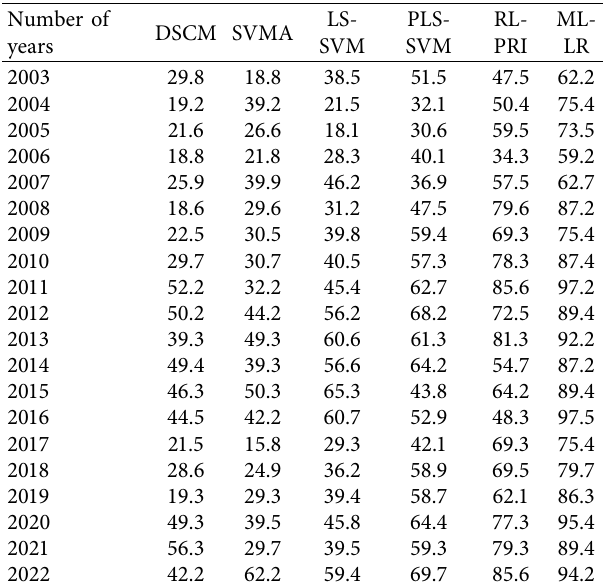
Table 2: Supply chain finance business in